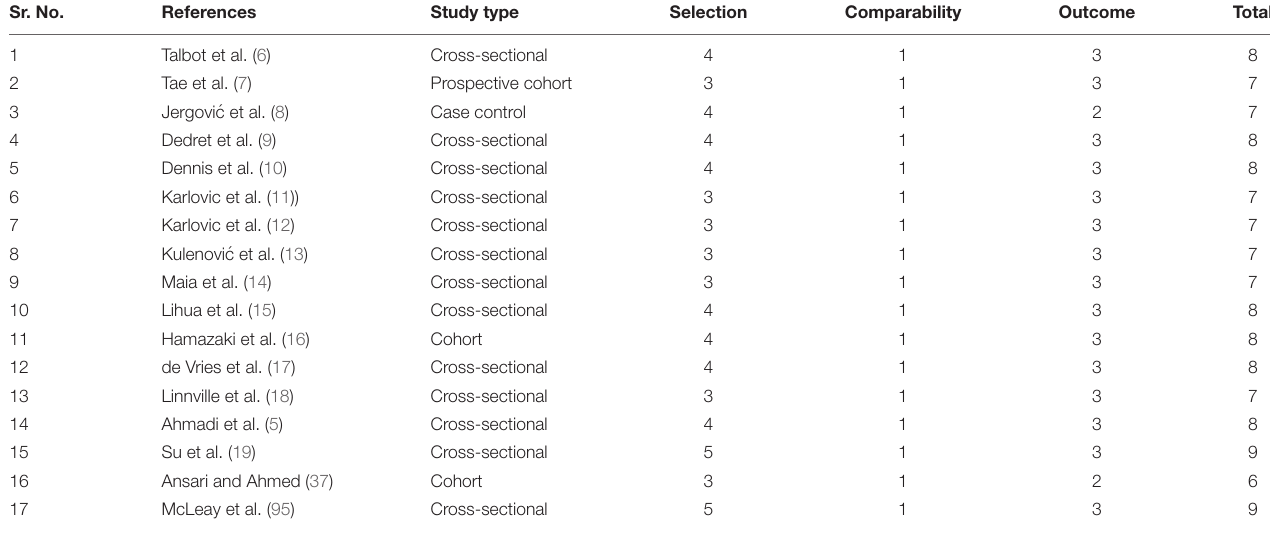
TABLE 3 | Quality assessment of